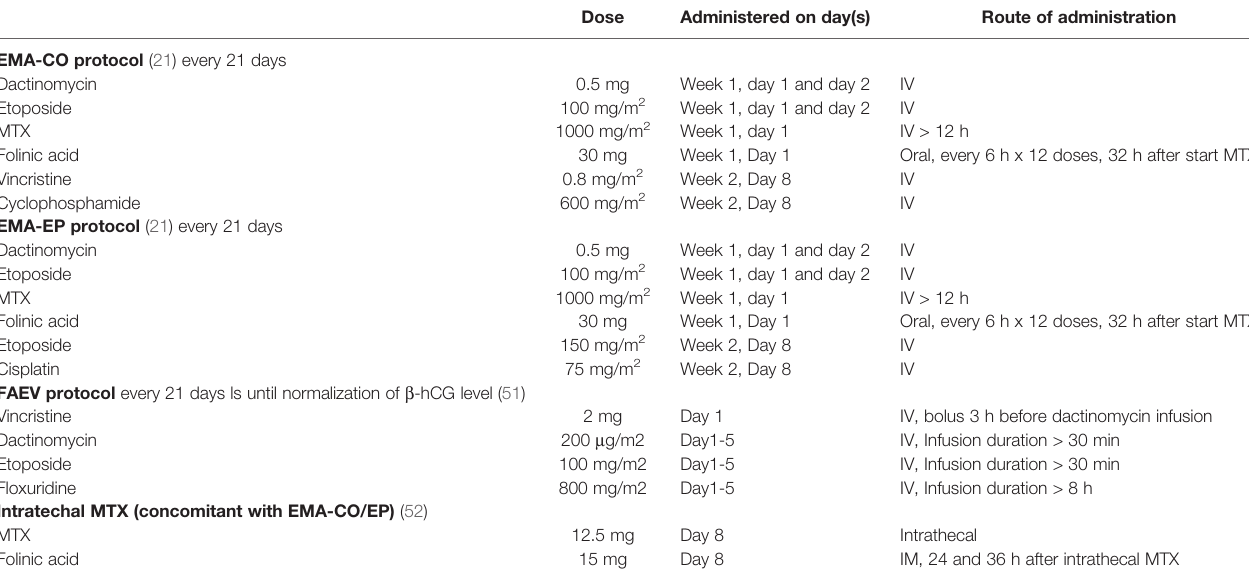
TABLE 2 | most common multidrug regimens used for treating BMs from GTN.